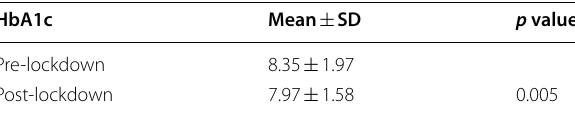
SD before and after ±